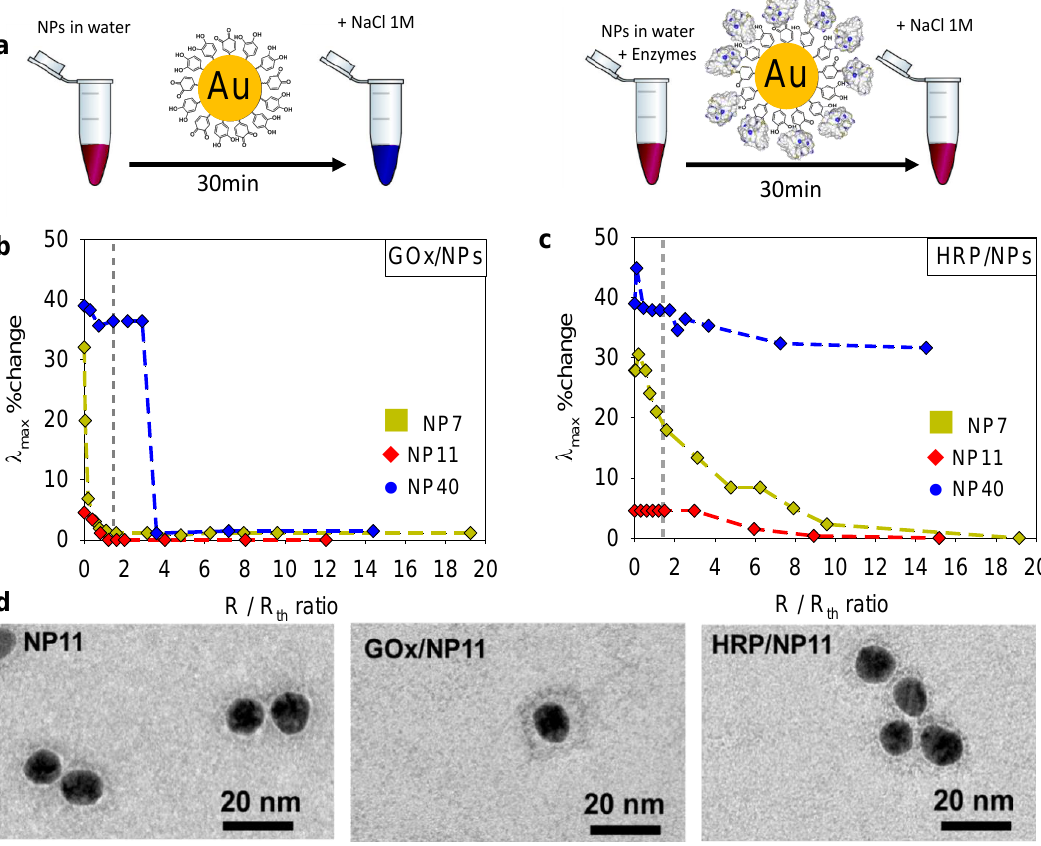
Figure 6. ( a ) Illustration of the gold NPs flocculation assay performed at 1 M NaCl in the absence and the presence of the enzyme. ( b , c ) Evolution of the relative change in λ max (i.e., the shift in wavelength/ λ max (NP)) as a function of the mixture ratio, R / R th of ( b ) the GOx/NPs suspensions, and ( c ) the HRP/NPs suspensions with NP7, NP11, and NP40. ( d ) TEM images of NP11, GOx/NP11 and HRP/NP11 bioconjugates, both obtained at R / R th = 10 after uranyl acetate negative staining. In the presence of HRP (44 kDa), the NPs aggregation is fully prevented for larger values of R / R th , i.e., 12 for NP7, and 9 for NP11. We can notice that partial prevention of the aggregation is observed for lower R / R th values, indicating the effective adsorption of some HRP at the surface of NPs. In the case of NP40, the aggregation was observed for all the tested values of R / R th . Finally, the enzyme/NPs bioconjugates were observed at R / R th = 10 by TEM after uranyl acetate negative staining (Figure 6d). In